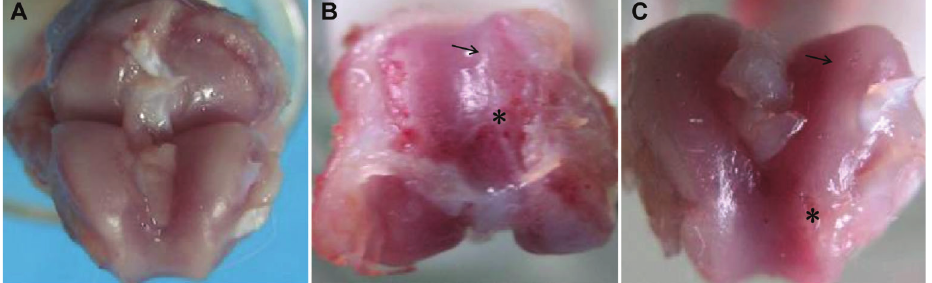
Figure 1. Representative images of femoral condyles at 12 weeks after surgery. A , The sham-operated (SP) group shows a normal appearance. B , In the anterior cruciate ligament transection (ACLT) + normal saline (NS) group with NS treatment after ACLT, the joints developed surface damage (arrow) and severe osteophytes (asterisk). C , The ACLT + anti-tumor necrosis factor- a antibody (ATNF) group shows a signi fi cant reduction in surface damage (arrow) and smaller osteophytes (asterisk).